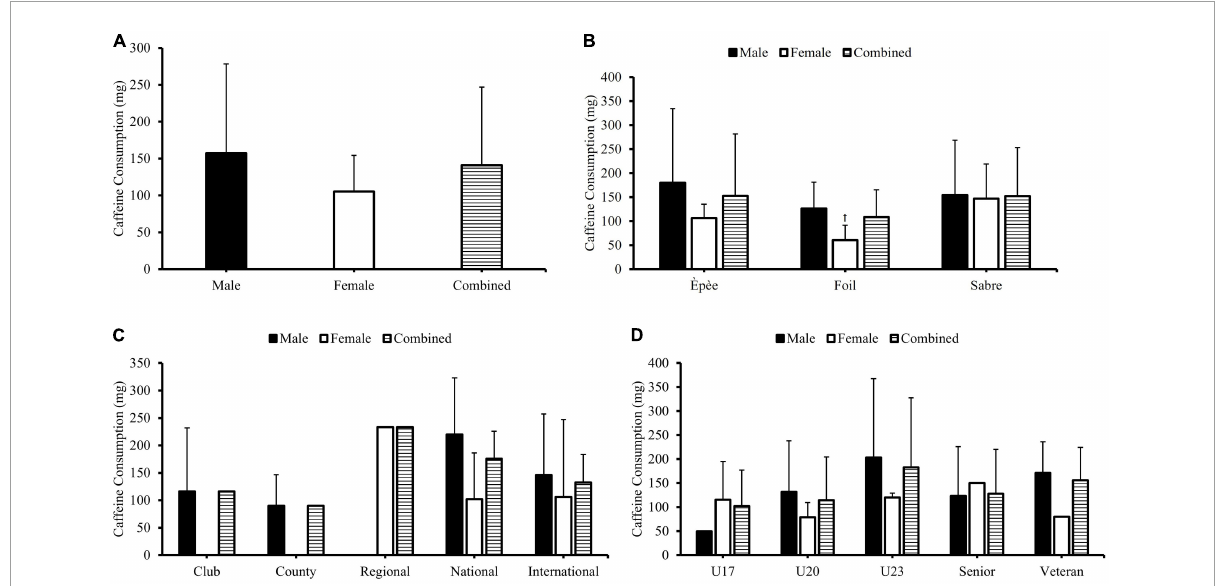
FIGURE3 The differences in the typical caffeine consumption of British Fencing athletes, before (1-h preceding)/during fencing training and/or competition (specific caffeine consumption) when comparing sex (A) , fencing discipline participated in panel (B) , competition level (C) , and age group (D) , within British Fencing athletes. † A statistically significant difference ( p < 0.05) in the specific caffeine consumption of females, in relation to males, who trained/competed in the foil fencing